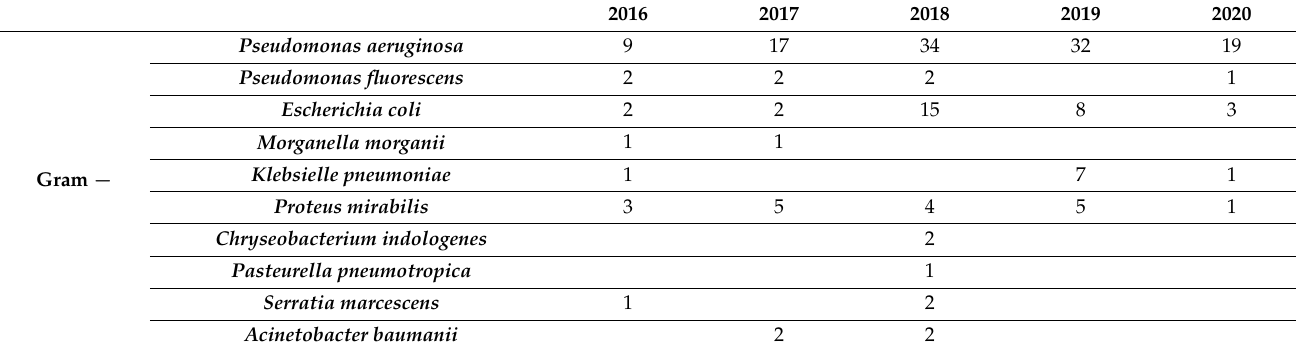
Table 4. Distribution of the most frequently isolated bacteria associated with an CIA